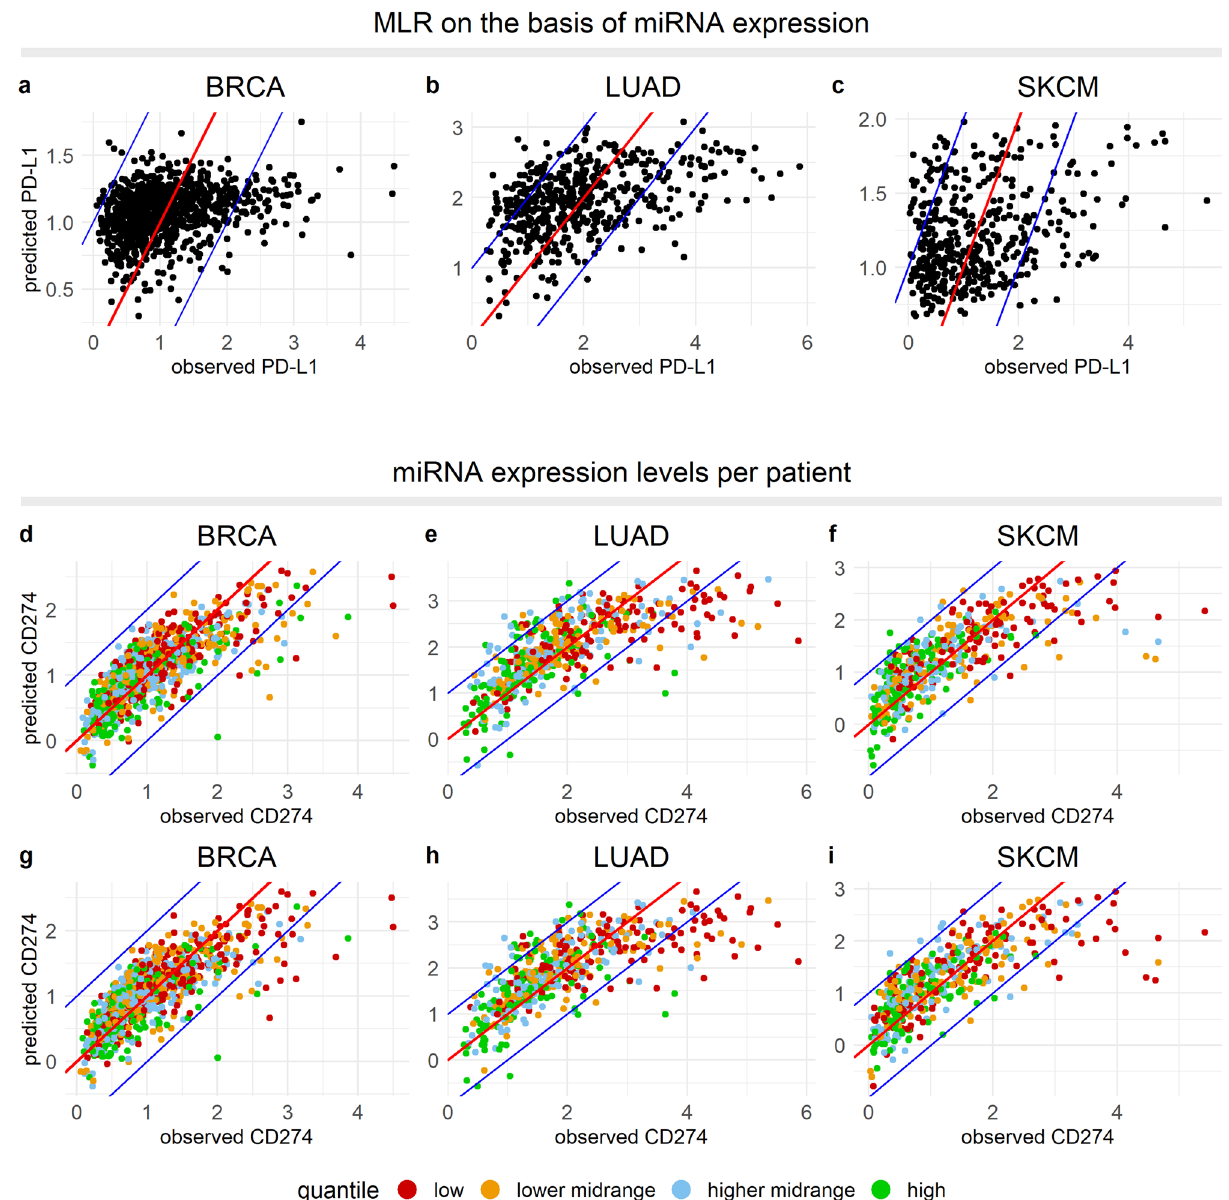
Figure 4. miRNAs partially explain patients with high CD274 expression. ( a–c ) MLR model based on the average expression of miRNAs associated with a negative regulation of CD274. ( d–i ) Patients were divided into quantiles based on the average expression of miRNAs identified as negative regulators of CD274 based on only the accurately predicted group ( d–f ), or based on the total patient population ( g–i ). Color indicates the quantile associated with a patient. In all panels the cancer type is indicated above the